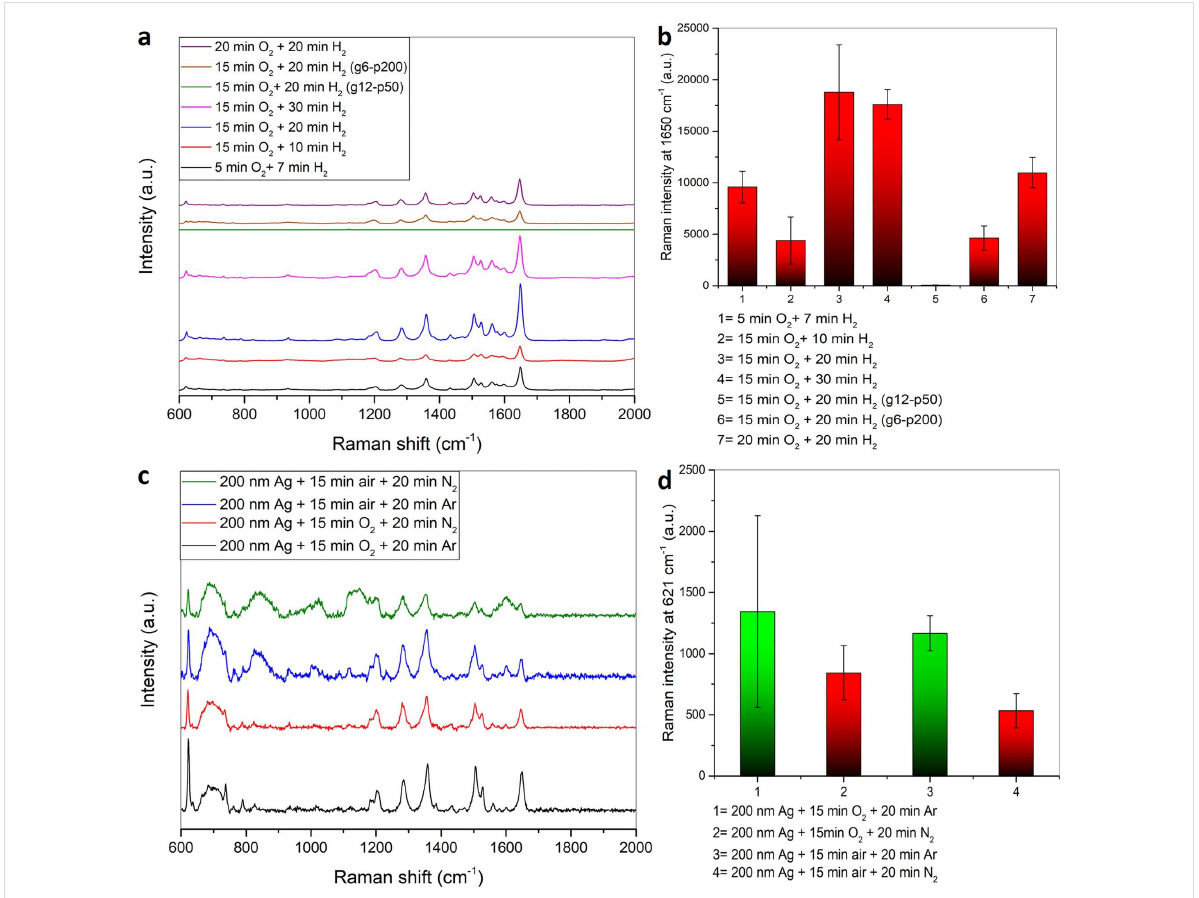
Figure 14: (a) SERS spectra of 10 − 6 M RhB on a 200 nm silver film treated with different times and parameters of oxygen and hydrogen plasma using 514.5 nm laser as excitation source. (b) Comparison of the average Raman intensities at 1650 cm − 1 . (c) SERS spectra of 10 − 6 M RhB on a 200 nm silver film treated with different oxidizing and reducing plasmas using 632.8 nm laser. (d) Comparison of the average Raman intensities at 621 cm − 1